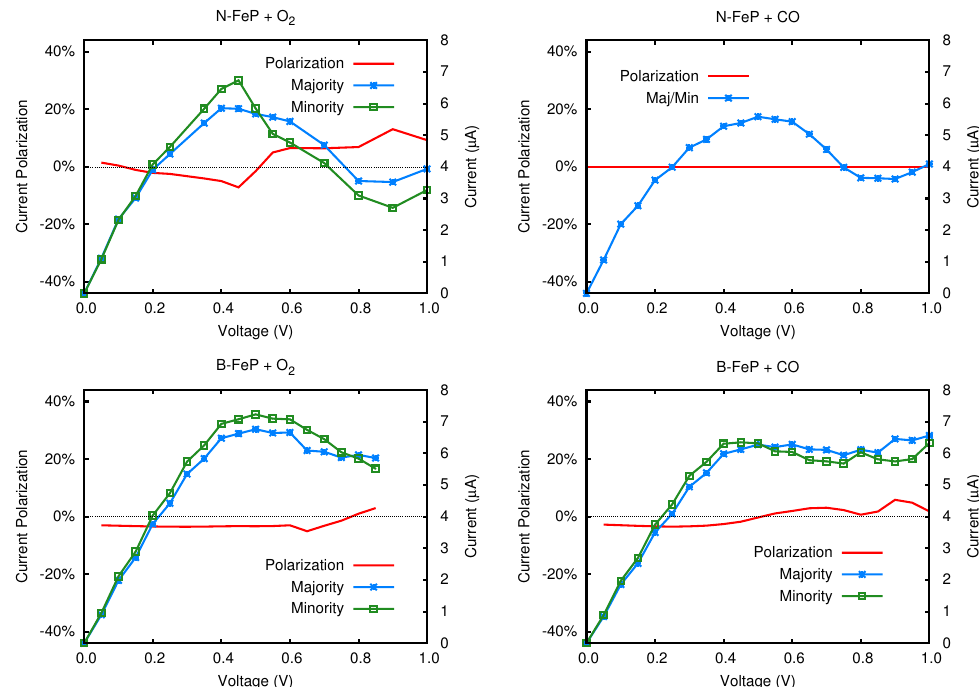
Figure 15. I ( V ) curves for the B- and N-doped nanojunctions with O 2 and CO adsorbed